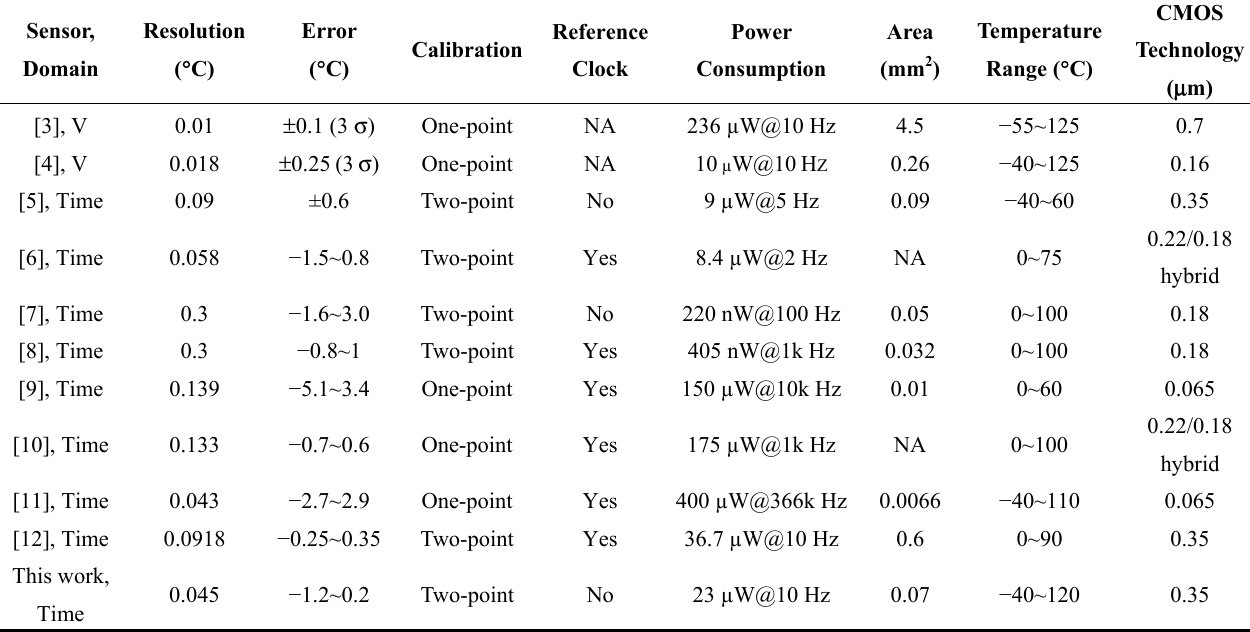
Table 1. Performances comparison among related time-domain smart temperature